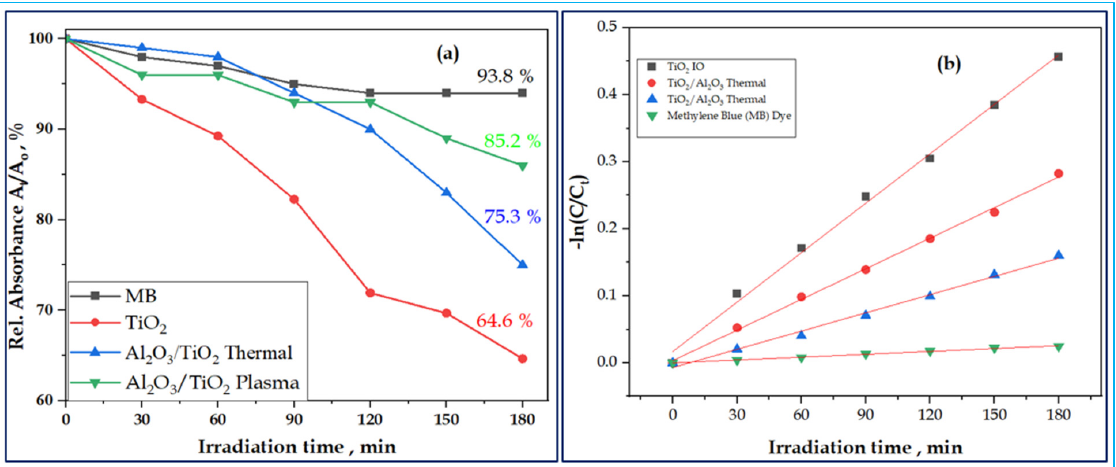
Figure 8. Photocatalytic performance—relative absorbance in % vs. irradiation time in minutes ( a ) and pseudo-first-order linear plots of ln (C 0 /C t ) vs. irradiation time for the kinetics of the sample materials ( b ).